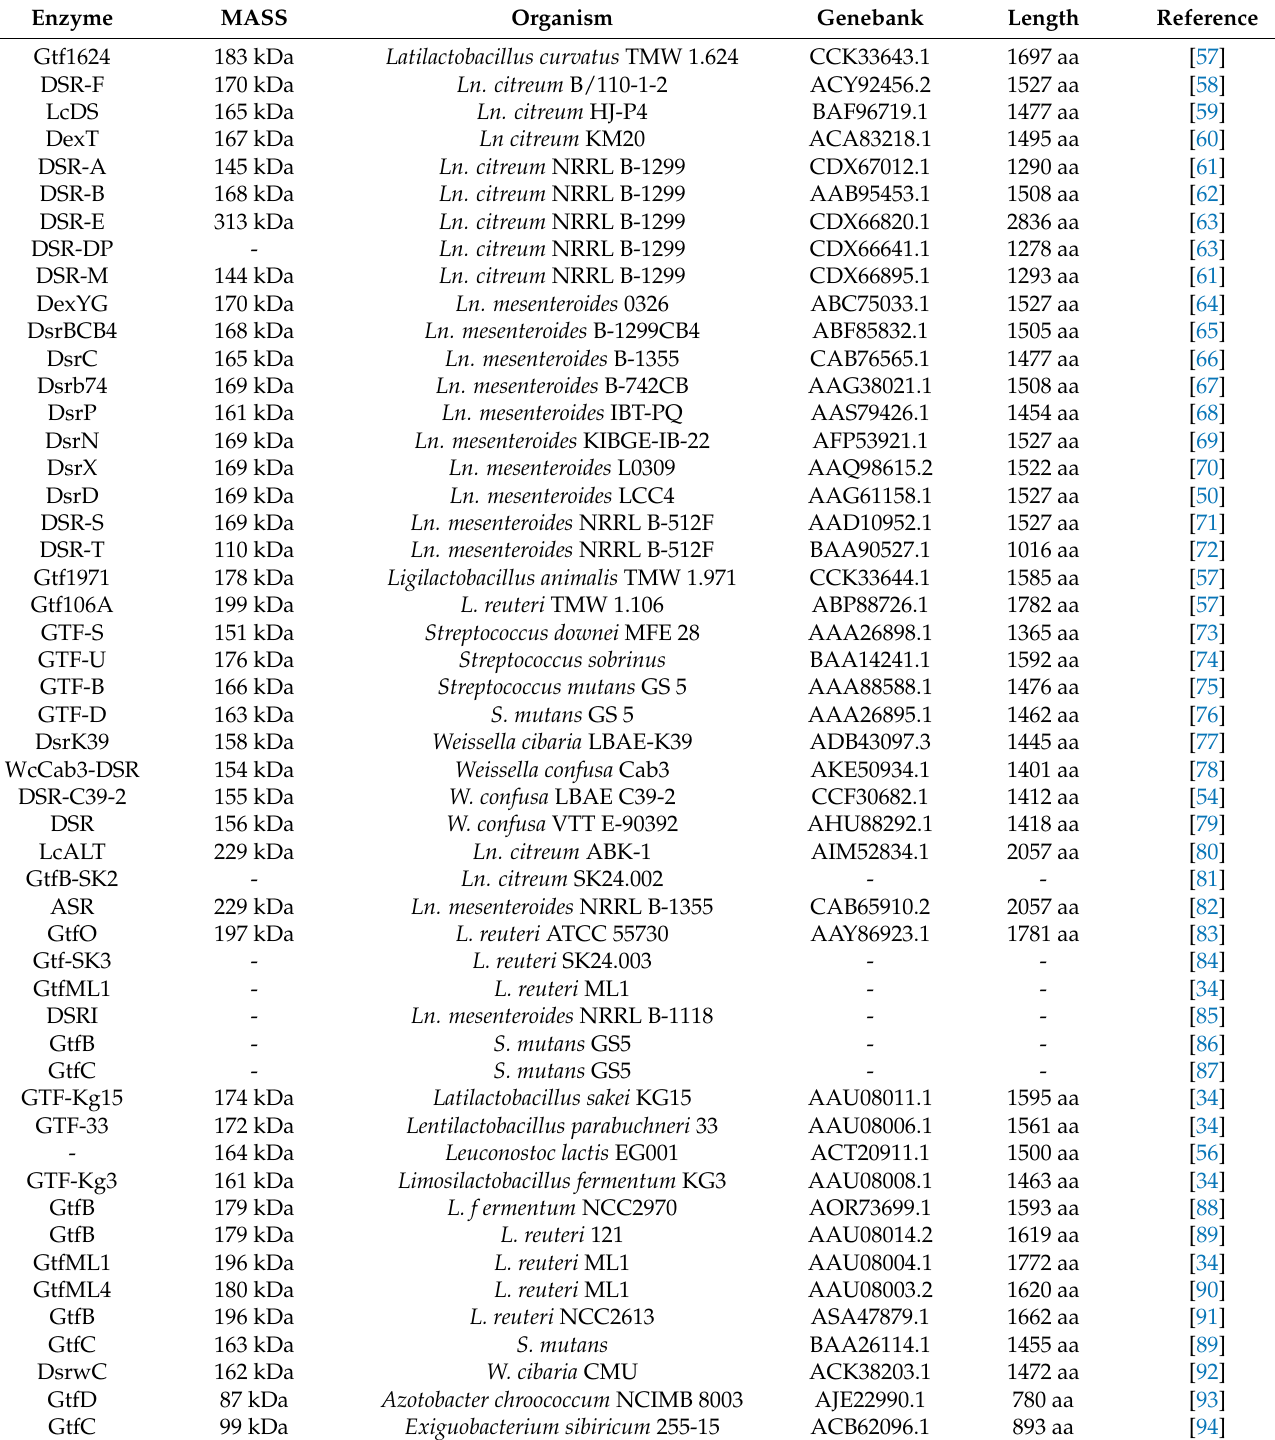
Table 1. Information on GS from different strains and their related properties in recent years was analyzed and collated using the CAZy